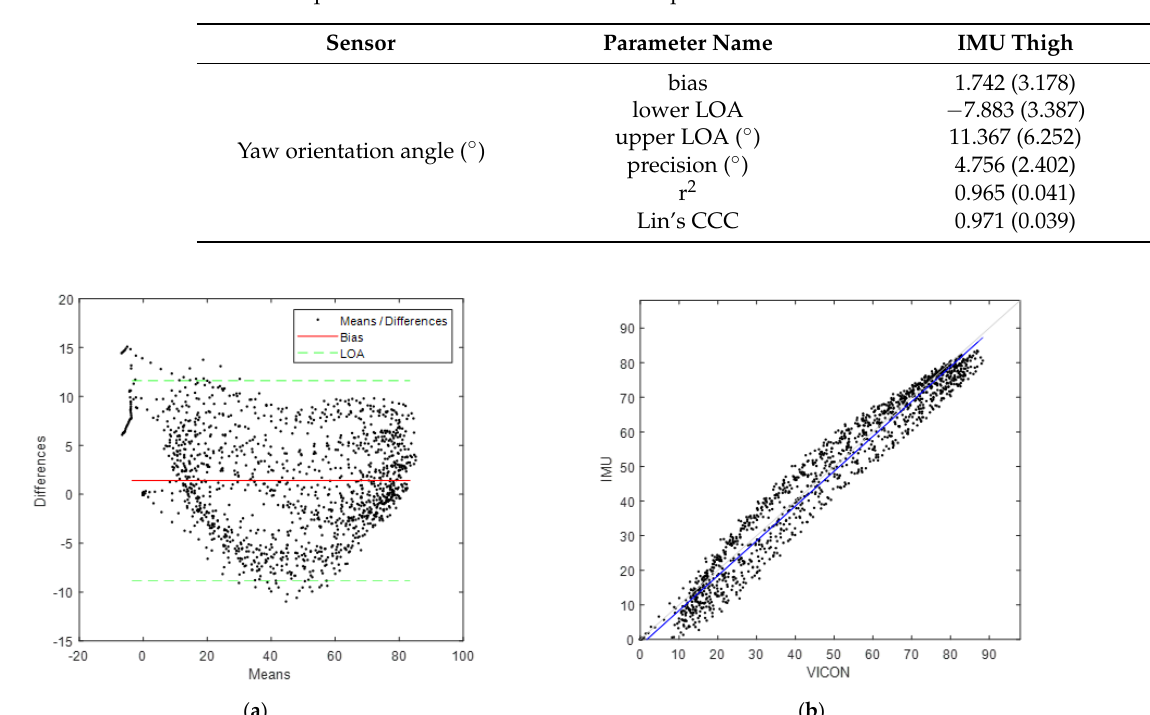
Figure 5. Bland-Altman plot of thigh yaw angle between IMU and VICON system. ( a ) The systematic bias (solid line) and the 95% limits of agreement (dashed line). ( b ) The linear regression (solid line) and the 45 ◦ line (dashed